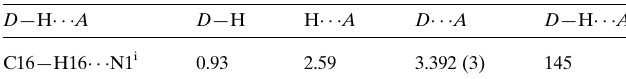
Table 1 Hydrogen-bond geometry (A˚ , (cid:2) ).